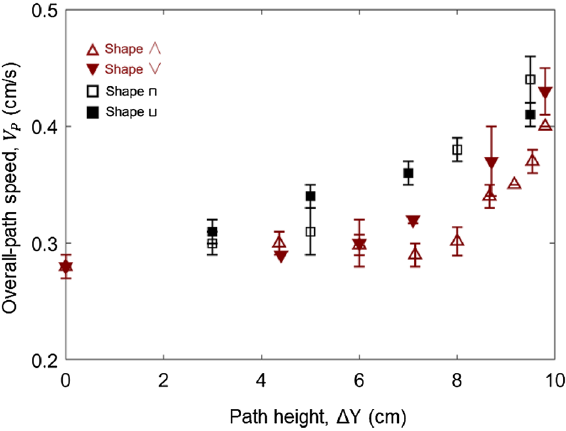
Figure 4. The overall-path speed ( V P ) vs. concave directions for the 0.8-mm wires.